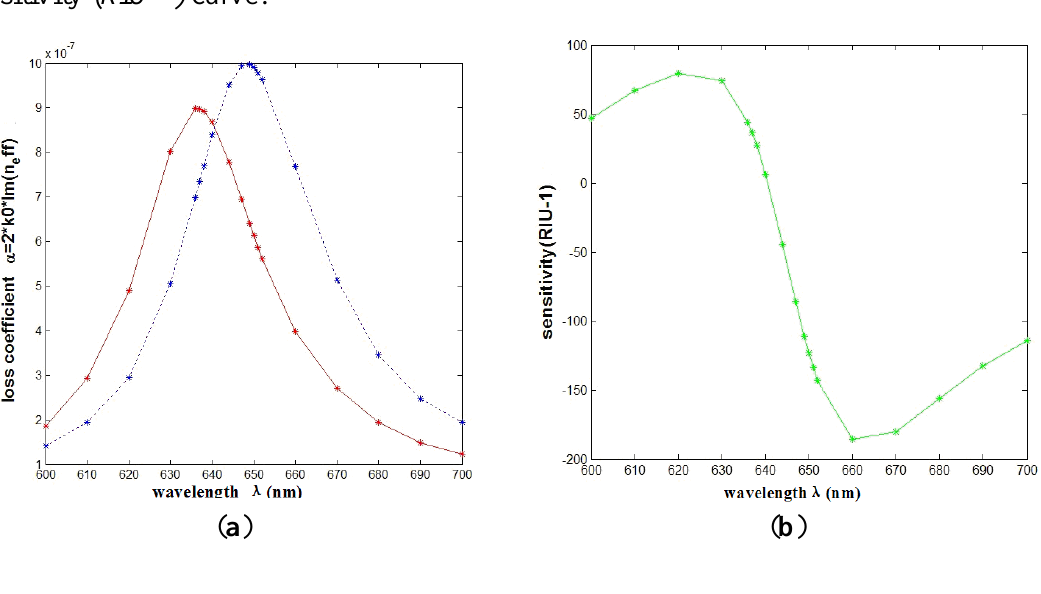
Figure 9. ( a ) The curves of attenuation constant of the fundamental mode of the grapefruit PCF irregularly filled with three nanowires. The red and blue curves represent the refractive indices of the samples are 1.33 and 1.335, respectively; ( b ) Intensity detection sensitivity (RIU −1 )